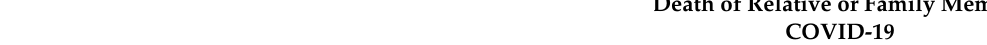
Table 8. Mann–Whitney U test for the comparison of the implemented preventive activities on stress perception between volunteers with a family member or relative who died from COVID-19 and those without. Legend: Me —median, IQR —interquartile range, Z —standardized statistics